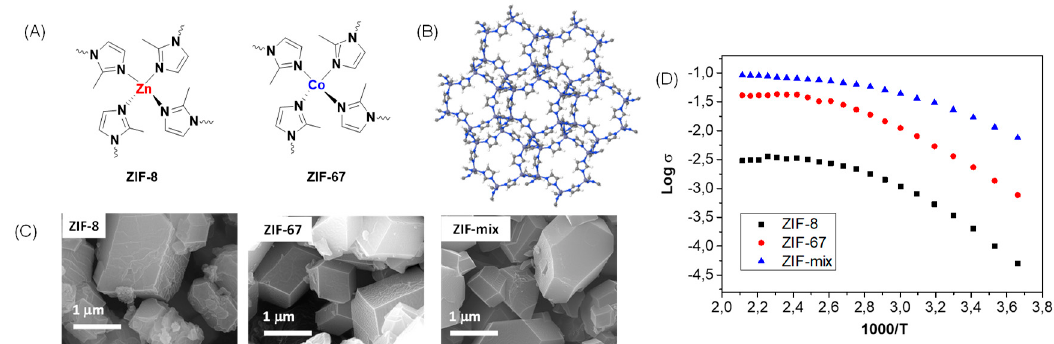
Figure 21. ( A ) Schematic representation of chemical structure of ZIF-8 and ZIF-69. ( B ) Structural representation of ZIF-8. ( C ) Field-emission scanning electron microscopy (FE-SEM) images of ZIF-8, ZI-67, and ZIF-mix. ( D ) Arrhenius plot of phosphoric acid doped PBI composite membranes containing 5 wt.% of ZIFs [77].